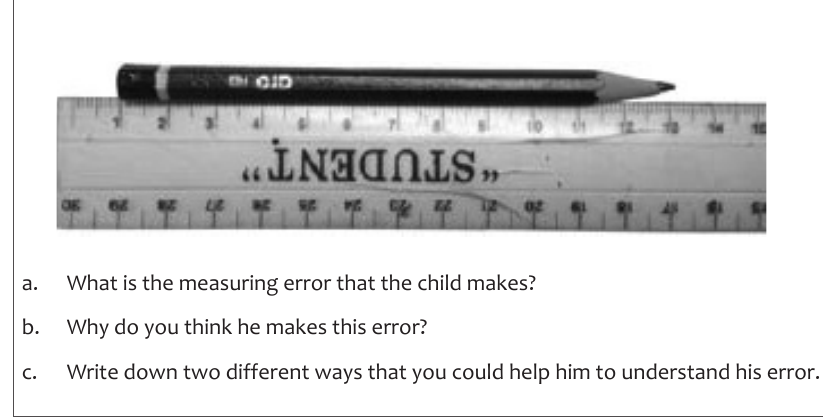
Figure 1: Question 14, designed to describe teachers’ ability to recognise a child’s error and identify the